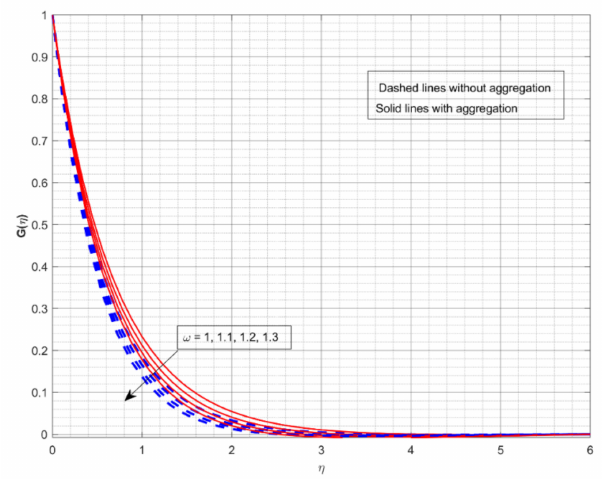
Figure 5. The impact of rotation-strength parameter on the velocity profile G ( η ) .